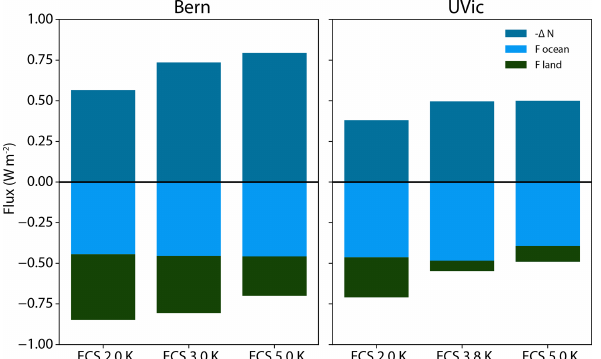
Figure 13. Energy fluxes following cessation of CO 2 emissions for the type A experiments (1%) for versions of Bern and UVic with varying equilibrium climate sensitivity. (cid:49)N is the change in ocean heat uptake relative to the time that emissions ceased. A reduction in ocean heat uptake will cause climate warming, hence − (cid:49)N is displayed. F ocean is the change in radiative forcing caused by ocean carbon uptake, and F land is the change in radiative forcing caused by terrestrial carbon uptake. All fluxes computed by averaging from 40 to 59 years after emissions